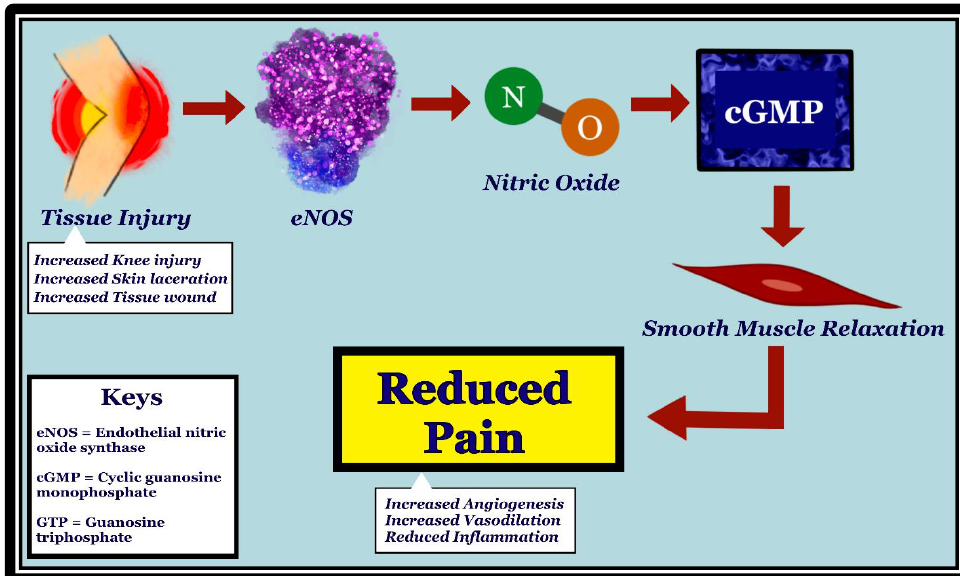
Figure 2. Mechanism of how initial tissue injury leads to pain reduction through activation of eNOS, production of nitric oxide (NO), and increase in cGMP. eNOS is stimulated in vascular endothelia by tissue injury, such as knee injury, skin laceration, and wounds. NO, which is produced by eNOS, diffuses to the vascular smooth muscle cells. Upon stimulation by NO, guanylate cyclase converts GTP to cGMP, resulting in vascular smooth muscle relaxation. Vasodilation has been shown to be associated with pain reduction, possibly through reduced inflammation and increased